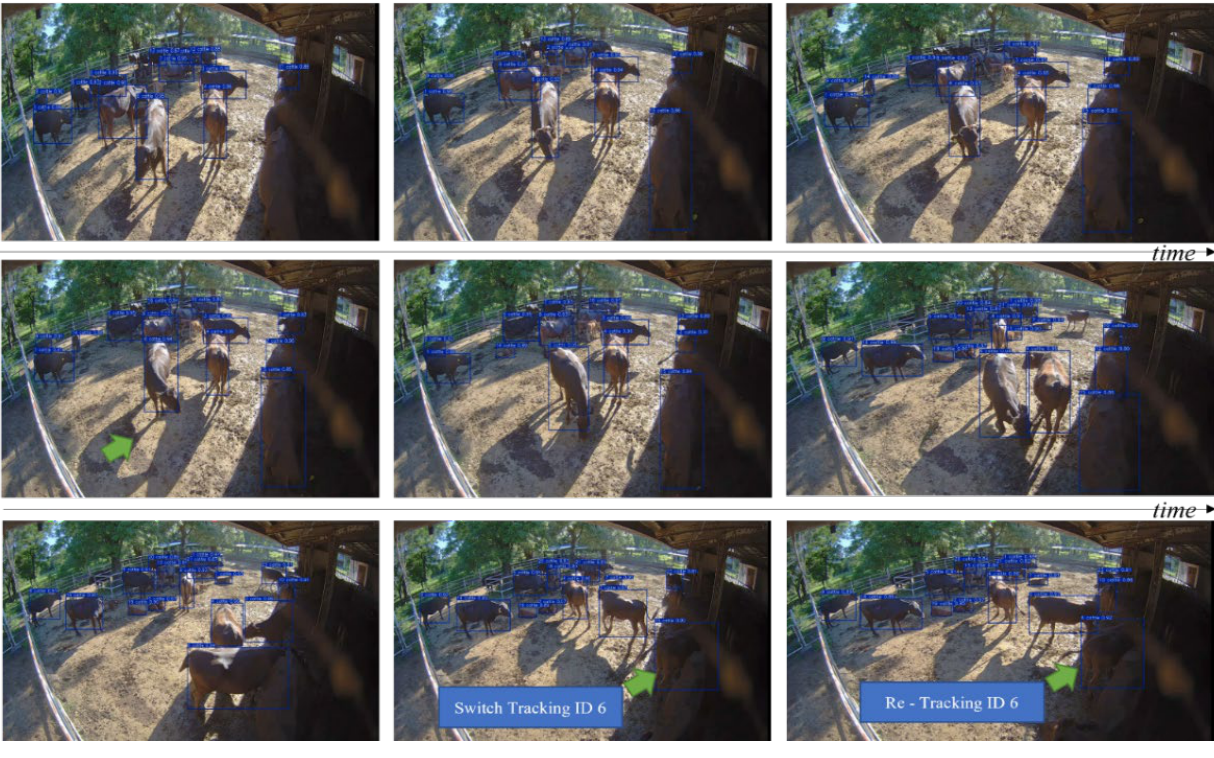
Figure 12. An analysis of the YOLO v5 with the Deep-SORT results.